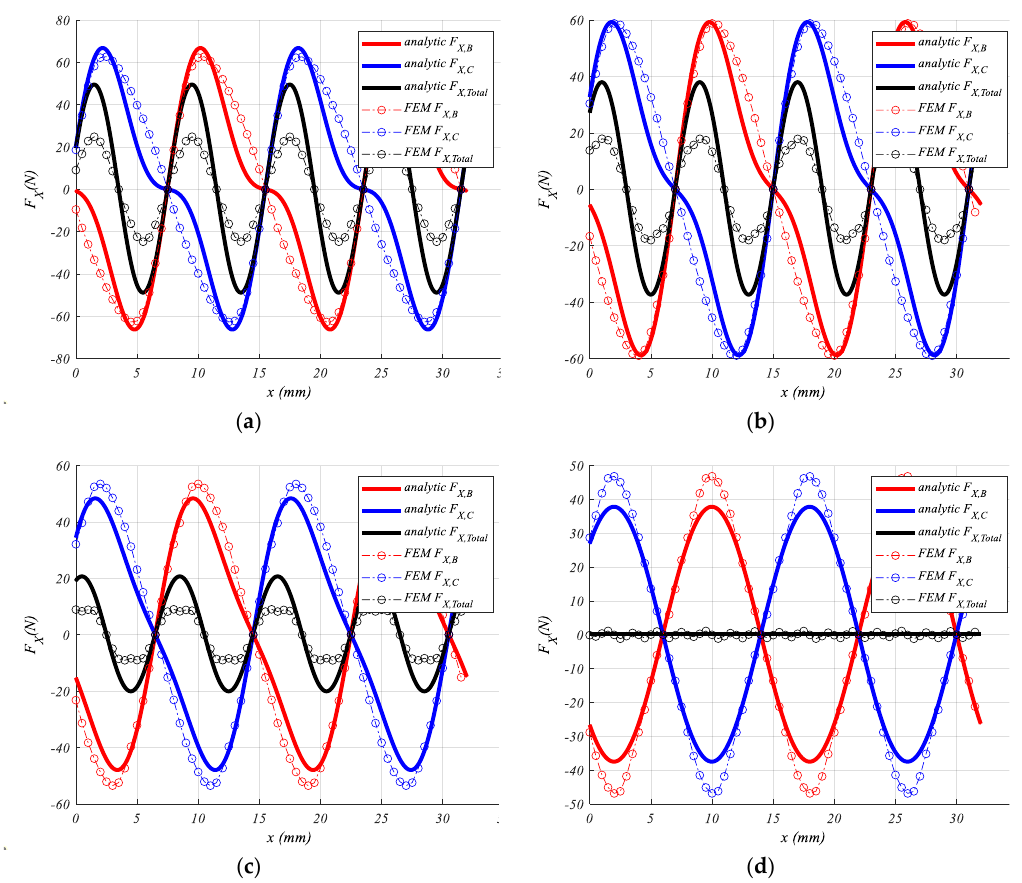
Figure 7. Detent force comparison results. ( a ) s = 1 mm. ( b ) s = 2 mm. ( c ) s = 3 mm. ( d ) s = 4 mm .